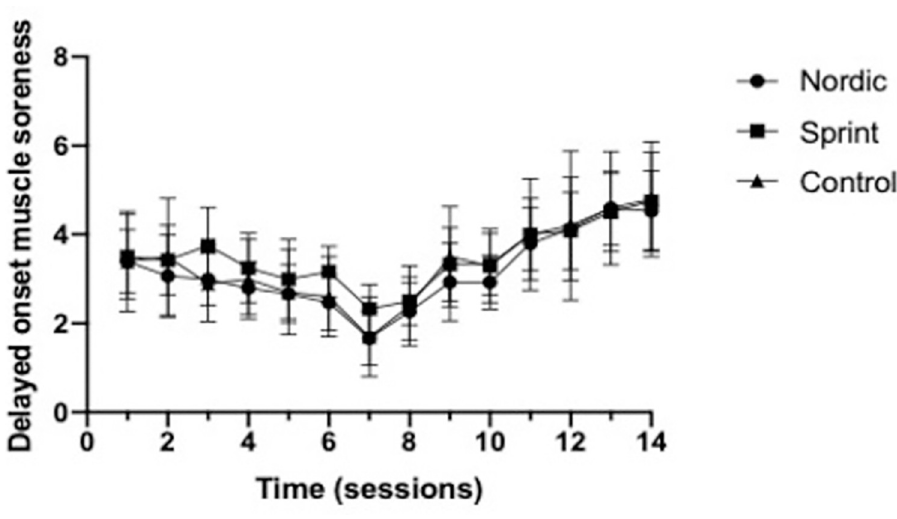
Fig 14. Mean ( ± 95%CI) 24-hr post soreness measured using a numeric pain rating scale (1–10) for the Nordic hamstring exercise, Sprint, and control groups.